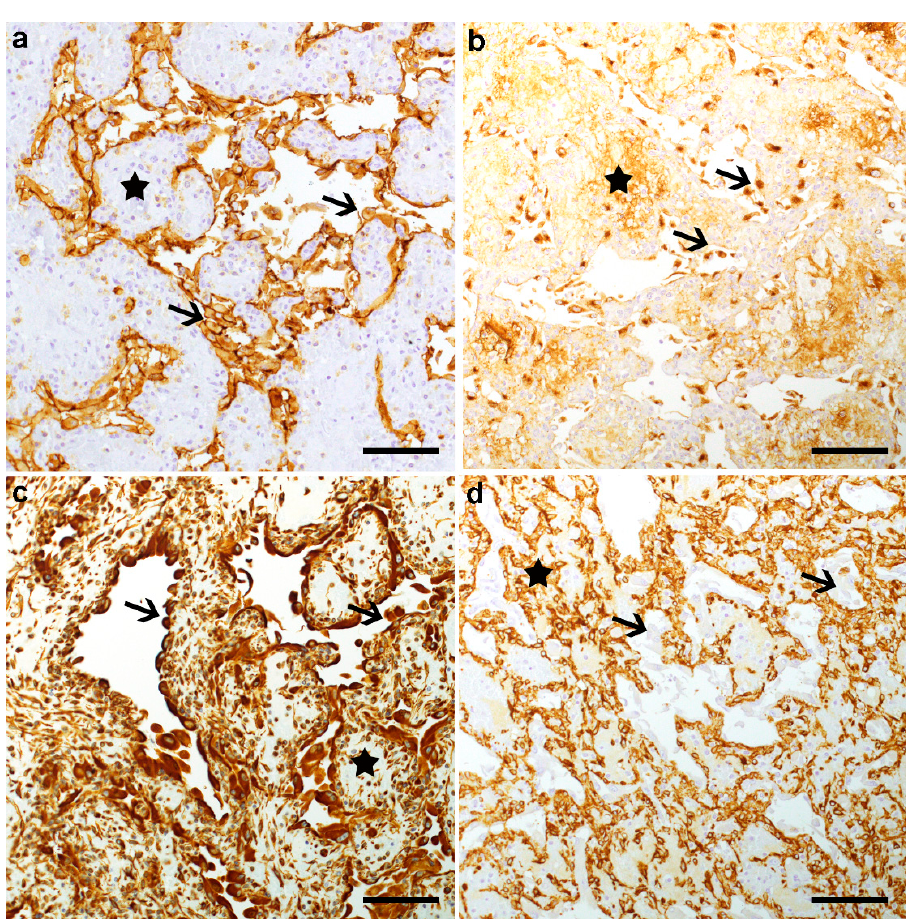
Figure 3. Immunohistochemical (IHC) analysis of a subcutaneous nodule from the BJA-affected Simmental calf with platelet endothelial cell adhesion molecule (PECAM-1) ( a ), von Willebrand factor ( b ), vimentin ( c ), and smooth muscle actin (SMA) ( d ). Note that the plump cells lining the cavities (arrows) displayed a strong positive signal in the PECAM-1, von Willebrand factor, and vimentin IHC but were negative in the SMA IHC. The stromal cells (stars) displayed a positive cytoplasmic signal in the vimentin and SMA IHC staining, while the signal seen in the von Willebrand factor IHC was considered to represent background staining. IHC staining, Hematoxylin counterstain, Bar 100 µm.